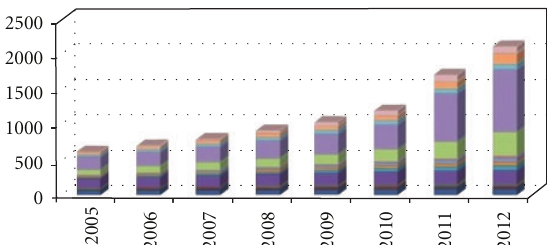
Figure 1: Graph showing the development of optical biosensor in the last decade.